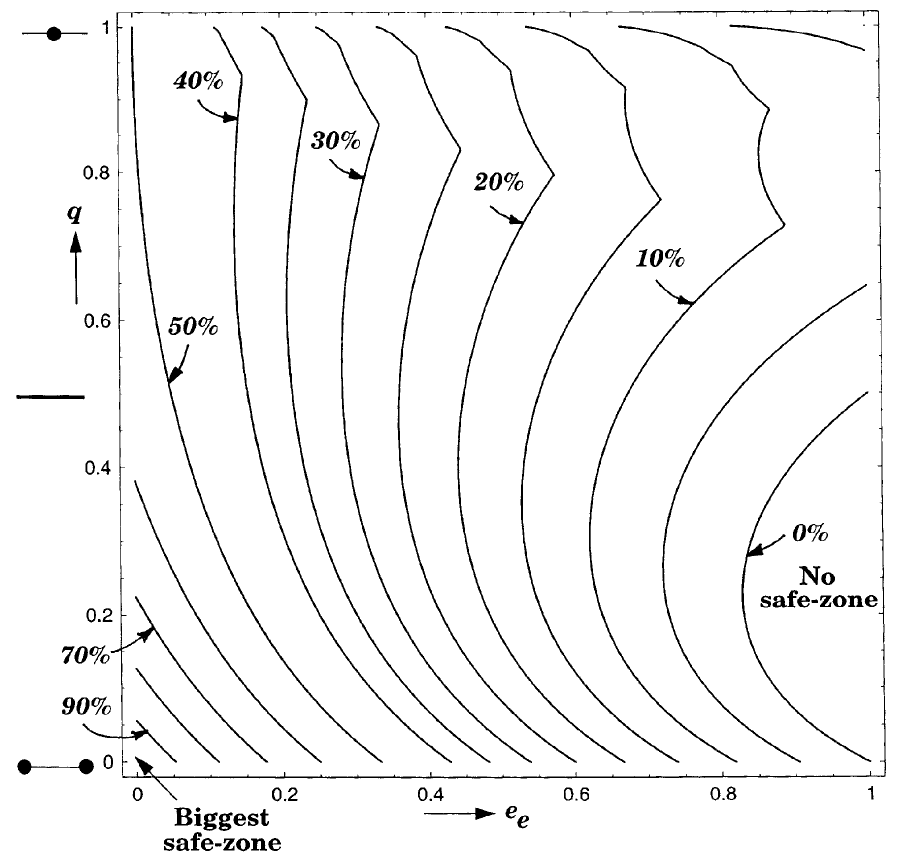
Fig. 6. Contour-plots of constant values of s for maximal velocity shock thresholds, ∆ v max s = v 0 during